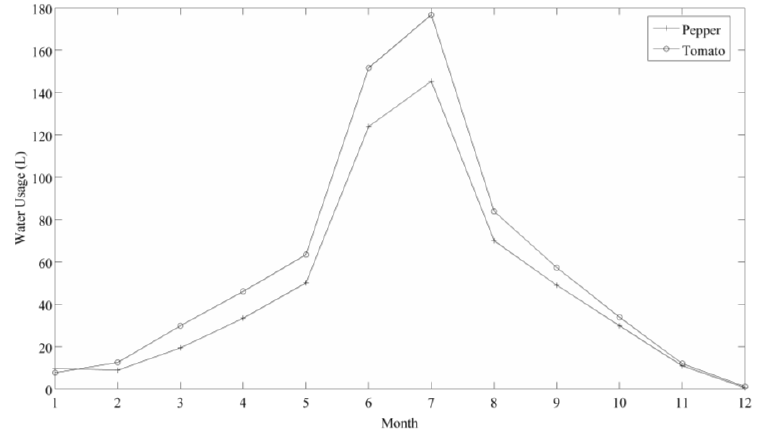
Figure 4. Monthly crop water usage.